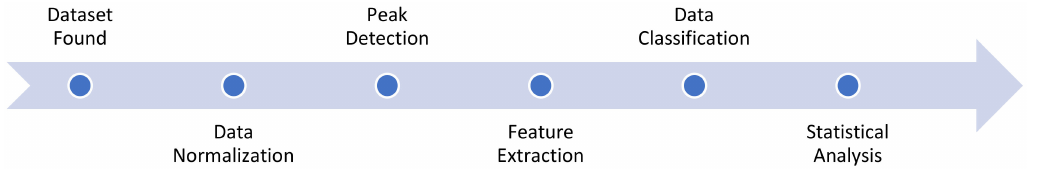
Figure 1. Schema of the data analysis and